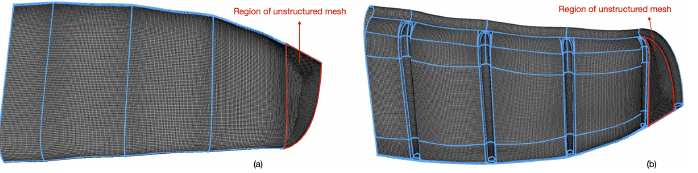
Figure 4. Surface mesh of the wing, adapted from [23]: ( a ) upper surface, ( b ) lower surface. For simulations without side-slip component of the inflow, only half of the wing is considered as the steady-state flow is expected to be symmetric. This was confirmed by an exemplary flow simulation for the full wing. For flow cases without side-slip, the wing is placed in a domain whose far field boundary is a hemisphere with a radius of 84 chord lengths from the wing. For flow cases with side-slip, the domain is a complete sphere. In both cases, the volume mesh is generated with the T-Rex algorithm of PointWise, which first extrudes the wing surface mesh with hexahedral cell fronts. The extrusion is stopped when one of the following criteria is met: cell isotropy is reached, cell fronts collide, quality of cells is below threshold, or the maximum number of hexahedral cell layers is reached. The latter is an input parameter which is set to 100 in this work. The minimum number of extruded layers is set to 5. Additionally, the growth rate of the extruded layers equals 1.15. When the hexahedral cell layers stop, the mesh algorithm generates tetrahedral cells in the rest of the domain. In this study, the boundary layer mesh at the wing surface uses a non-dimensional height y + (cid:28) 1 of the first cell. Good mesh qualities were obtained without hard constraints on the level of skewness of the mesh cells. The maximum cell angle was set to 170 ◦ . A slice through the volume mesh in the symmetry plane is shown in Figure 5.